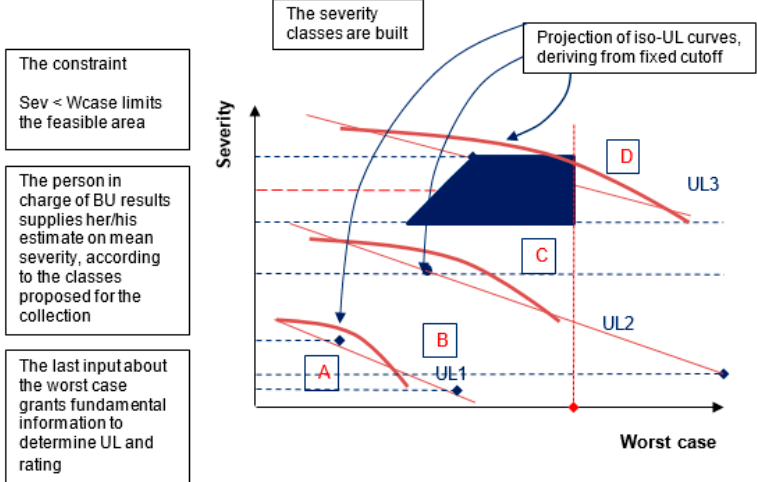
Figure 6. OpRSA Method constraints for range analysis. Source: author own study.